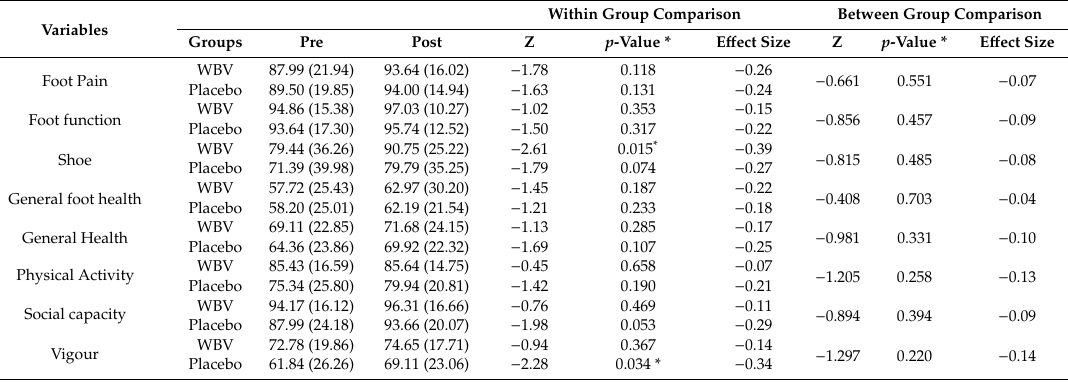
Table 4. Intent-to-treat of 8-weeks WBV training in the Foot Health Status Questionnaire (FHSQ) dimensions in people with T2DM.